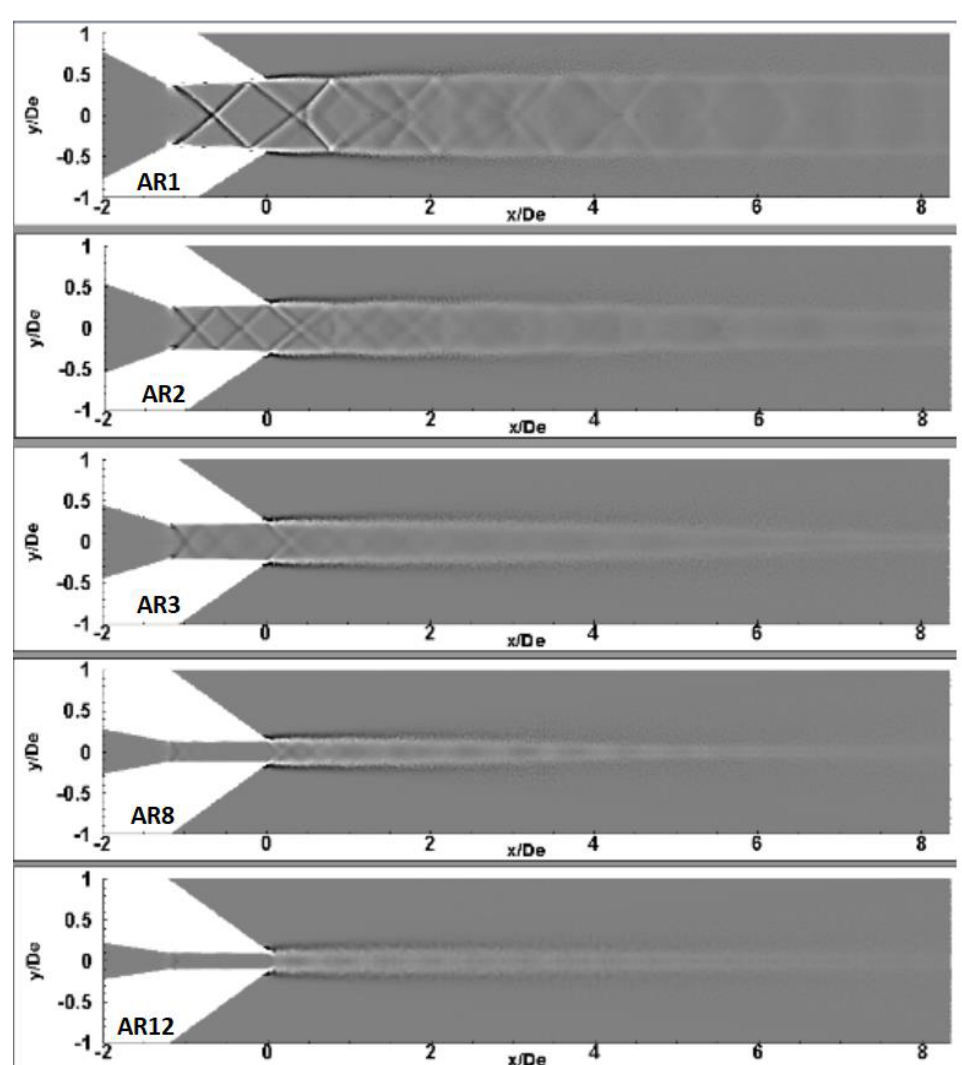
Figure 3. Numerical shadowgraph illustrating the shock propagation on minor axis symmetry plane for AR = 1, 2, 3, 8, 12. When the shock wave travels from the wall to the centerline, the boundary layer be- comes thicker in the AR2 nozzle (Figure 4) due to the adverse pressure gradient imposed by an oblique shock wave. Comparing with the AR12 nozzle, the boundary layer from the throat onwards is thin since the shocks are not as severe.